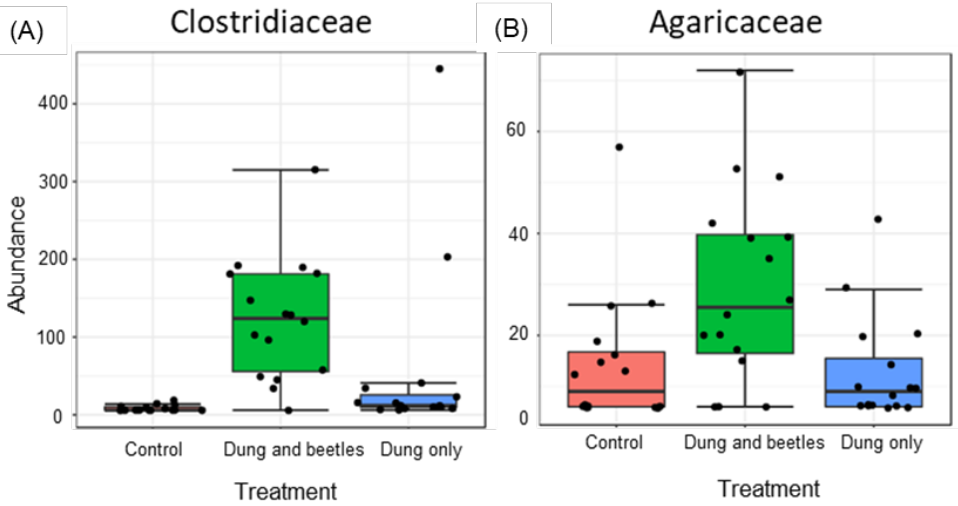
Figure 6. Linear discriminant analysis effect size, performed on bacterial and fungal classes, re-vealed a significant effect size of dung beetle activity for ( A ) the bacterial class Clostridiaceae and ( B ) fungal class Agaricaceae . Dark dots represent individual data points.